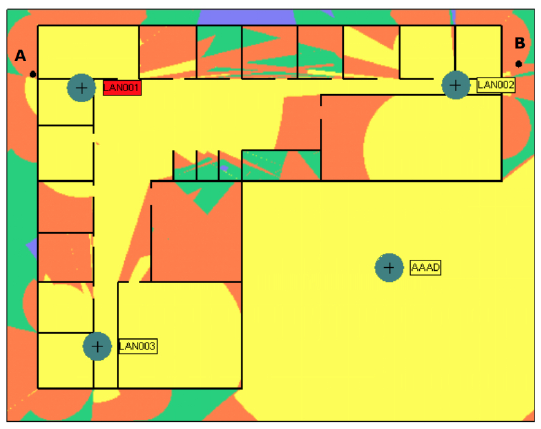
Figure 6. Heuristic site locations for indoor with multiple-input single-output (MISO) antennas.